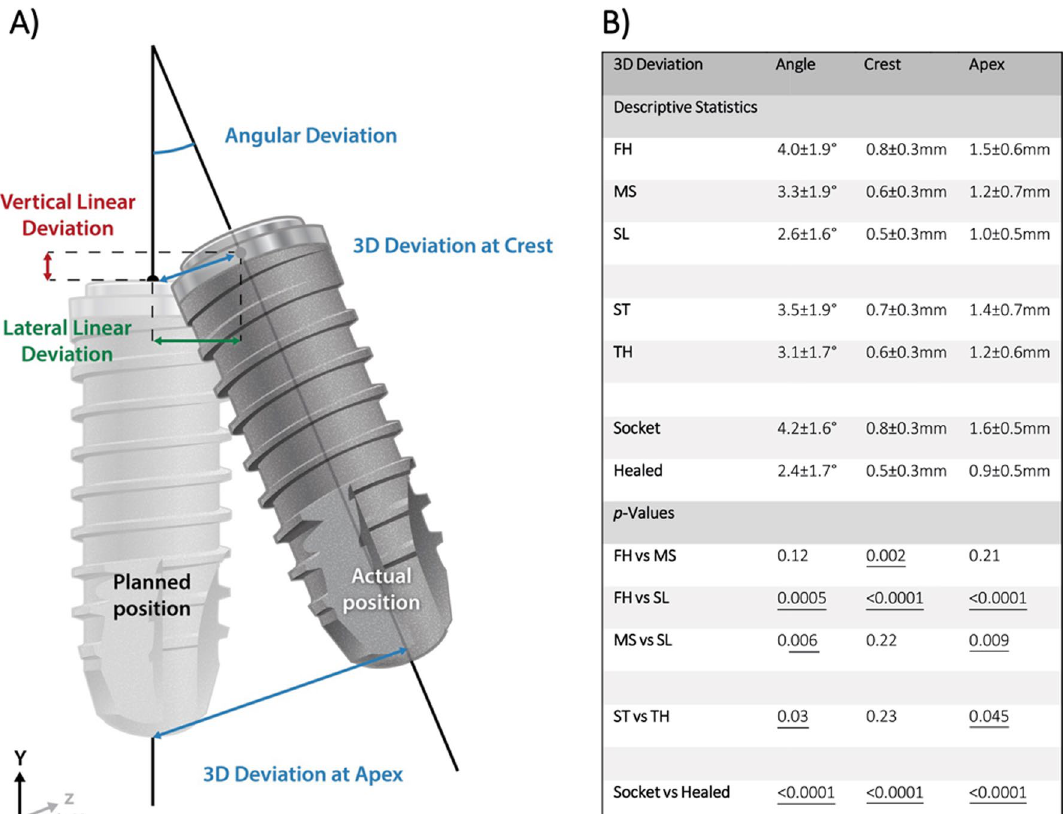
standard deviation) ±